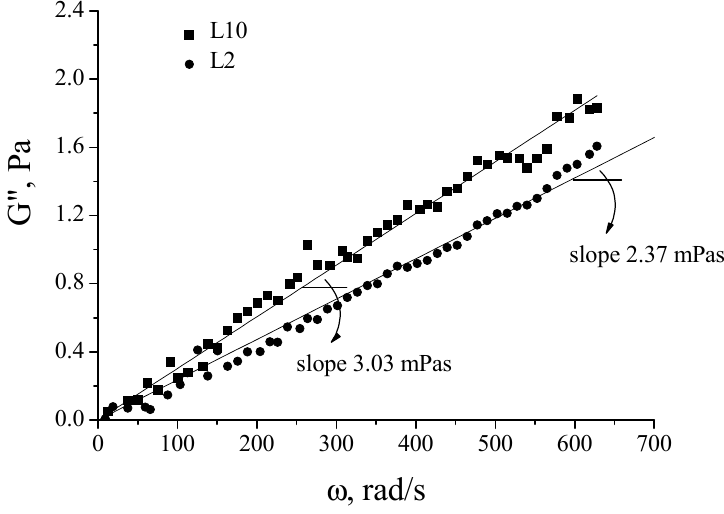
Figure 5. Variation of loss modulus as a function of angular frequency for latexes L2 ( ● ) and L10 ( ■